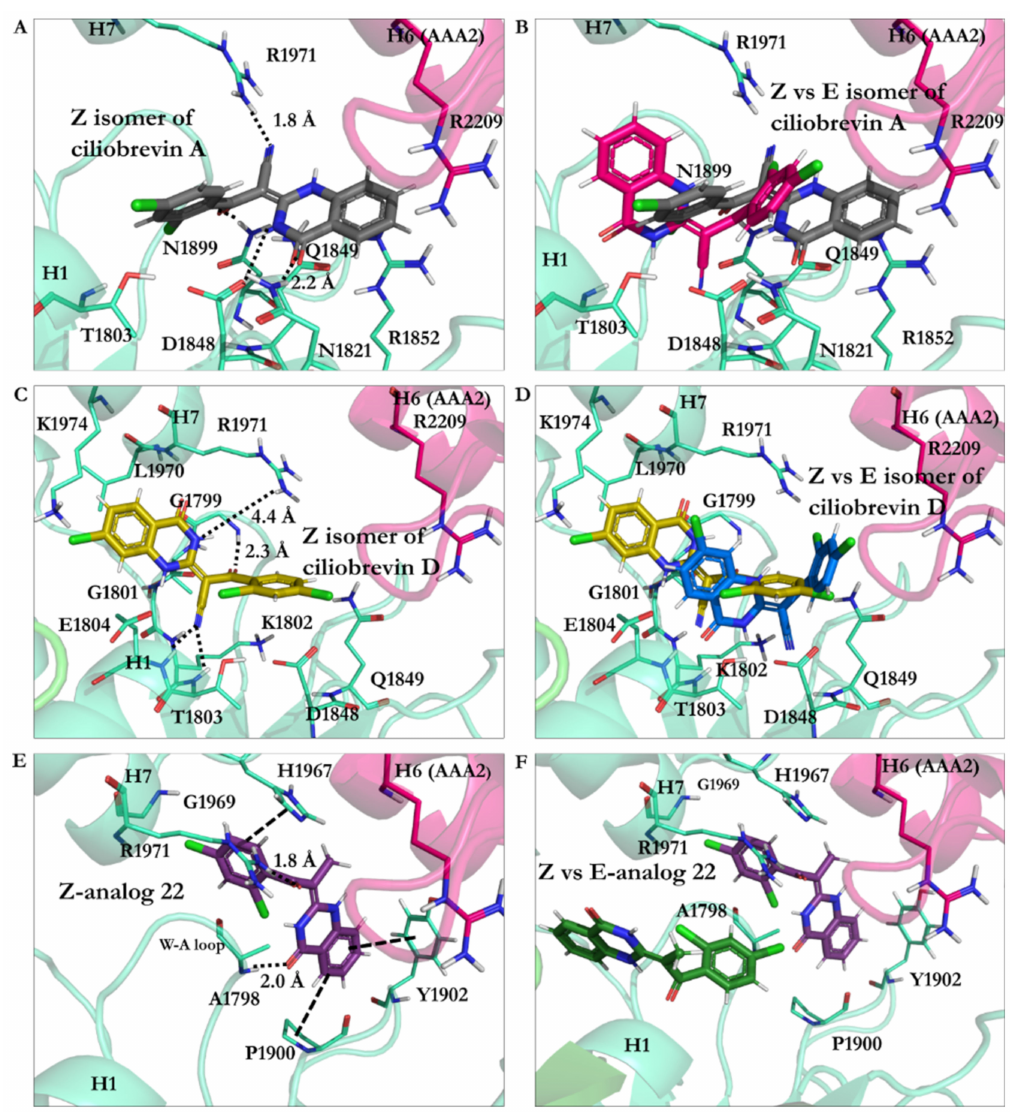
Figure 10. ( A ) Z isomer of ciliobrevin A at the AAA1 binding site of cytoplasmic dynein 1. ( B ) Superimposition of Z and E isomers of ciliobrevin A. ( C ) E isomer of ciliobrevin D at the AAA1 binding site of cytoplasmic dynein 1. ( D ) E isomer of ciliobrevin D superimposed on its Z isomer. ( E ) Z analogue 22 and the residues at the AAA1 binding site of AAA1. ( F ) Z analogue 22 superimposed on its E isomer at the AAA1 binding